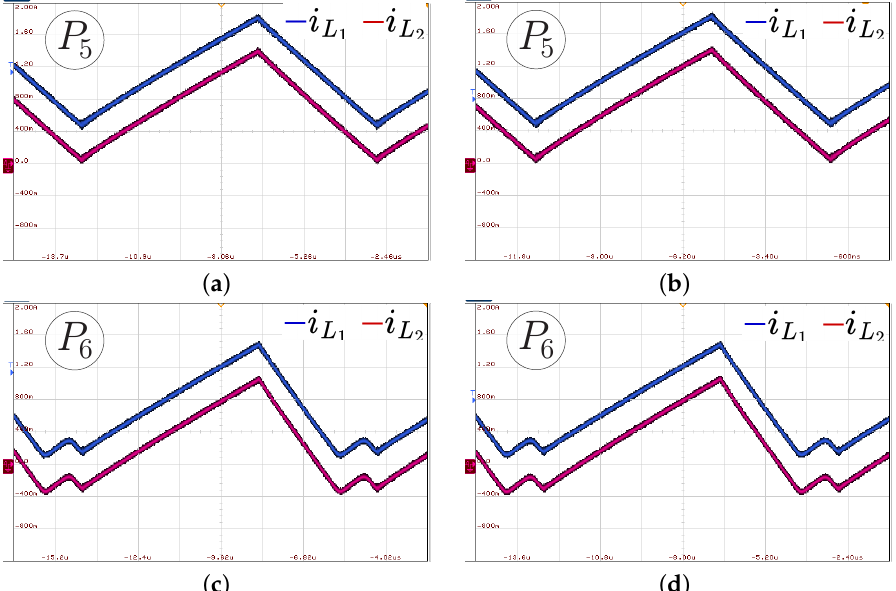
Figure 15. Inductor current waveforms in the open-loop control with a duty cycle of 0.6: ( a ) SEPIC in point P 5 , ( b ) ´Cuk in point P 5 , ( c ) SEPIC in point P 6 , and ( d ) ´Cuk in point P 6 , (400 mA/div, DC coupling, and a time base of 1.4 µ s).